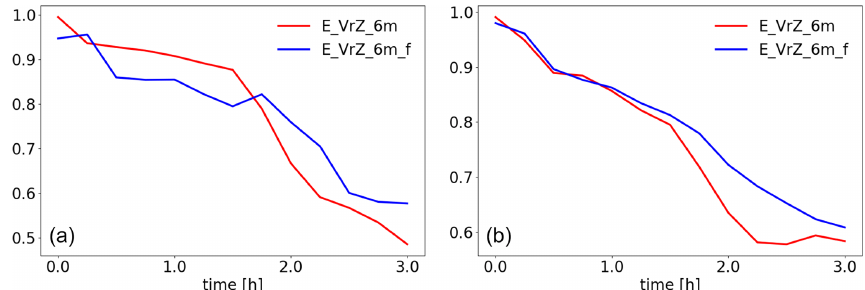
Figure 11. The FSS values of the deterministic (a) and ensemble forecasts (b) starting at 15:00UTC in E_VrZ_6m and E_VrZ_6m_f based on the reflectivity composite at 0 . 5 ◦ with the threshold value of 30dBZ and box lengths of 16km as a function of the forecast lead time up to 3h (with 15min outputs). The FSS values of ensemble forecasts are averaged over ensemble